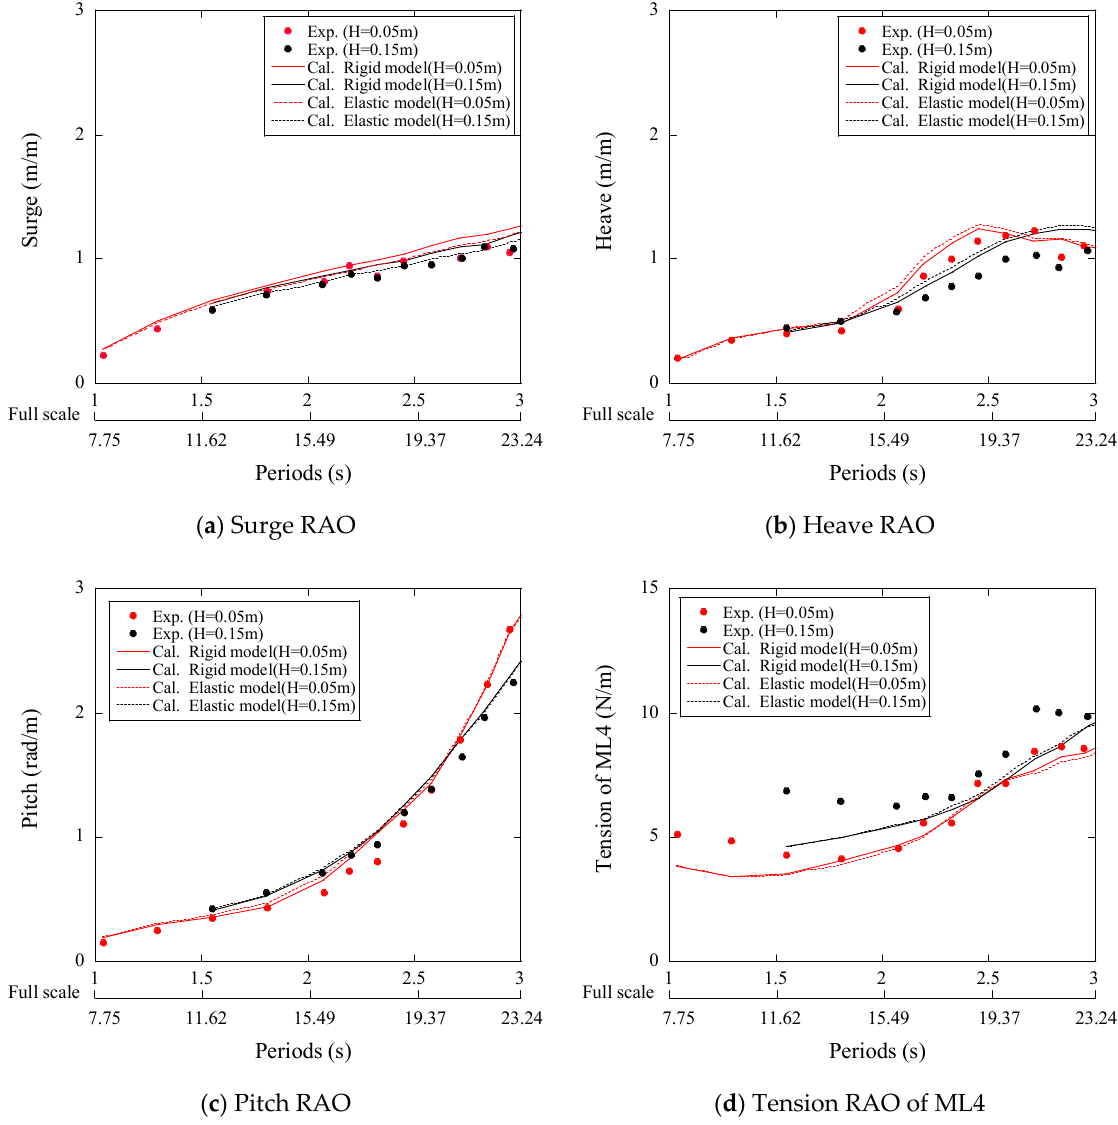
Figure 8. The predicted and measured RAOs (response amplitude operators) of the dynamic responses in the regular waves. The dynamic responses of the rigid and elastic models in the irregular waves are also predicted. The measured wave elevations are used as the inputs of the